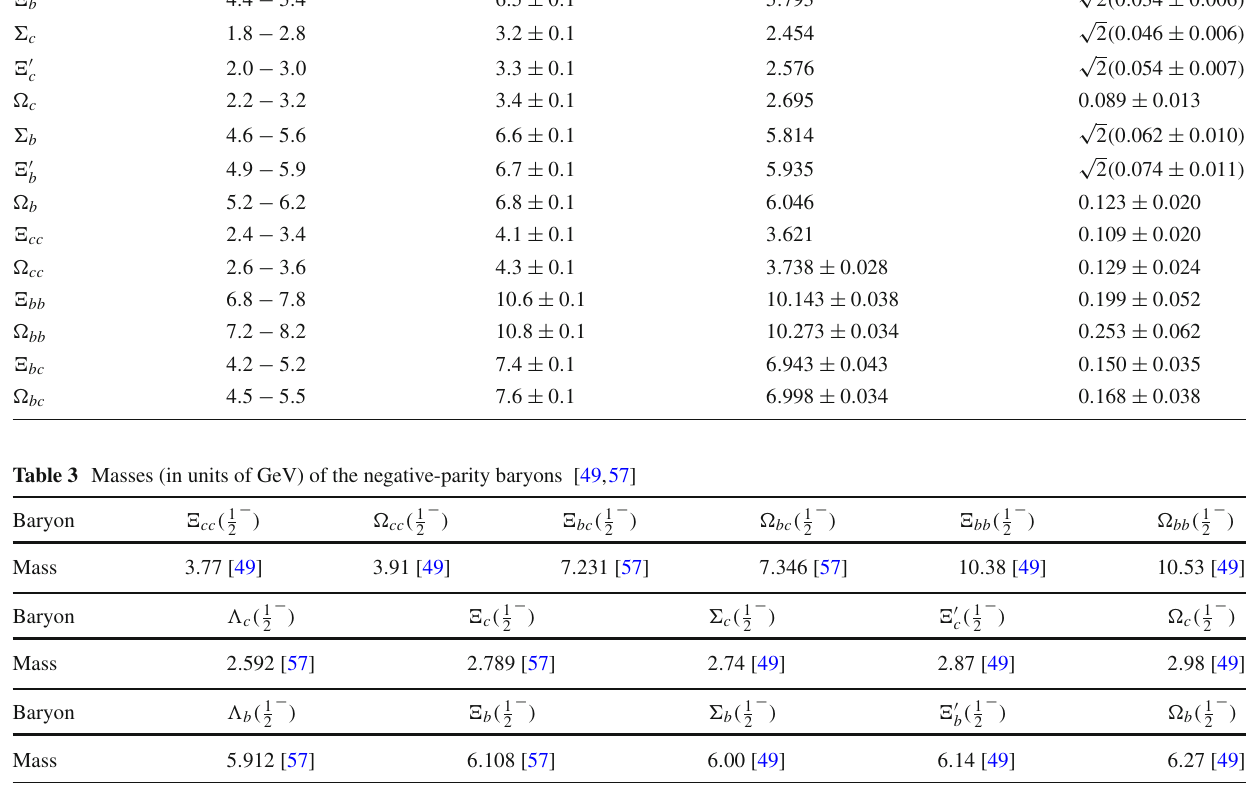
Table 4 Lifetimes (in units of fs) of doubly-heavy baryons. The lifetime of (cid:2) ++ cc comes from the experiment [2], and other results are theoretical predictions [45,58,59]